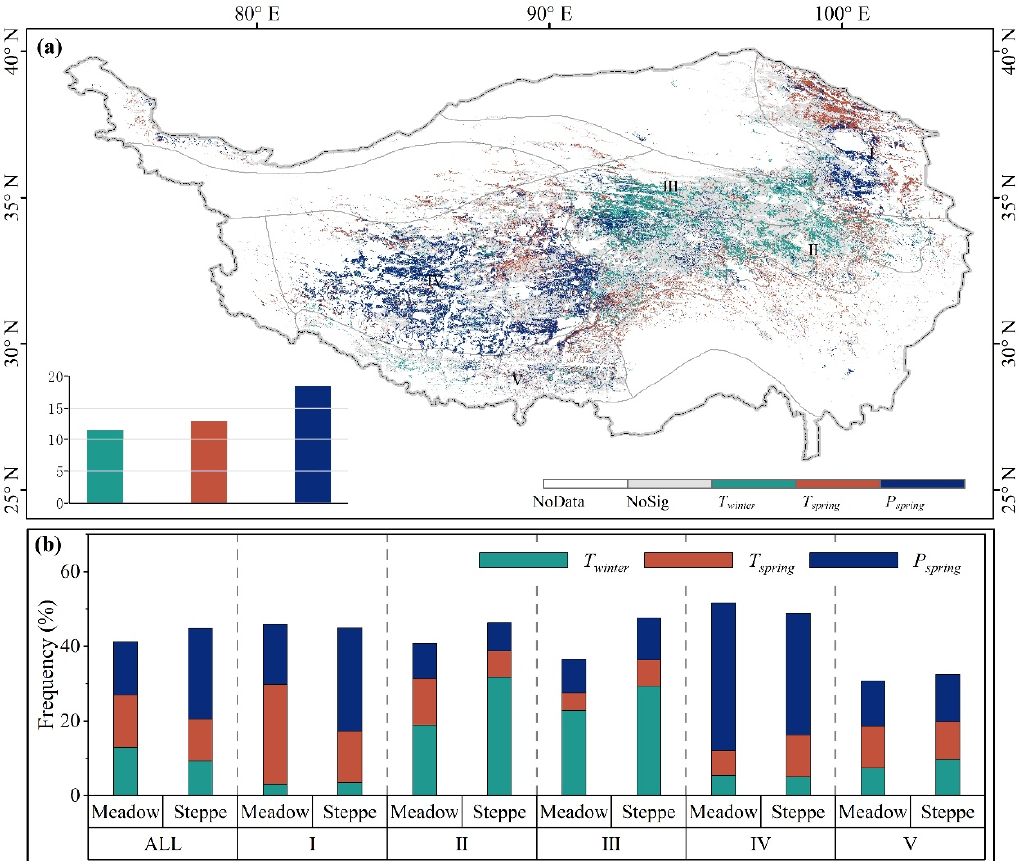
Figure 5. Spatial distribution of dominant drivers ( a ) and frequency of each dominating factor ( b ) in different ecoregions. Bottom-left inset in ( a ) shows proportion of corresponding dominating factors. Dominant drivers were determined by maximum individual contribution at p < 0.05 level. NoSig indicates that none of these factors was significant ( p > 0.05). All indicates entire plateau. I, II, III, IV, and V indicate different ecoregions following Figure 1.